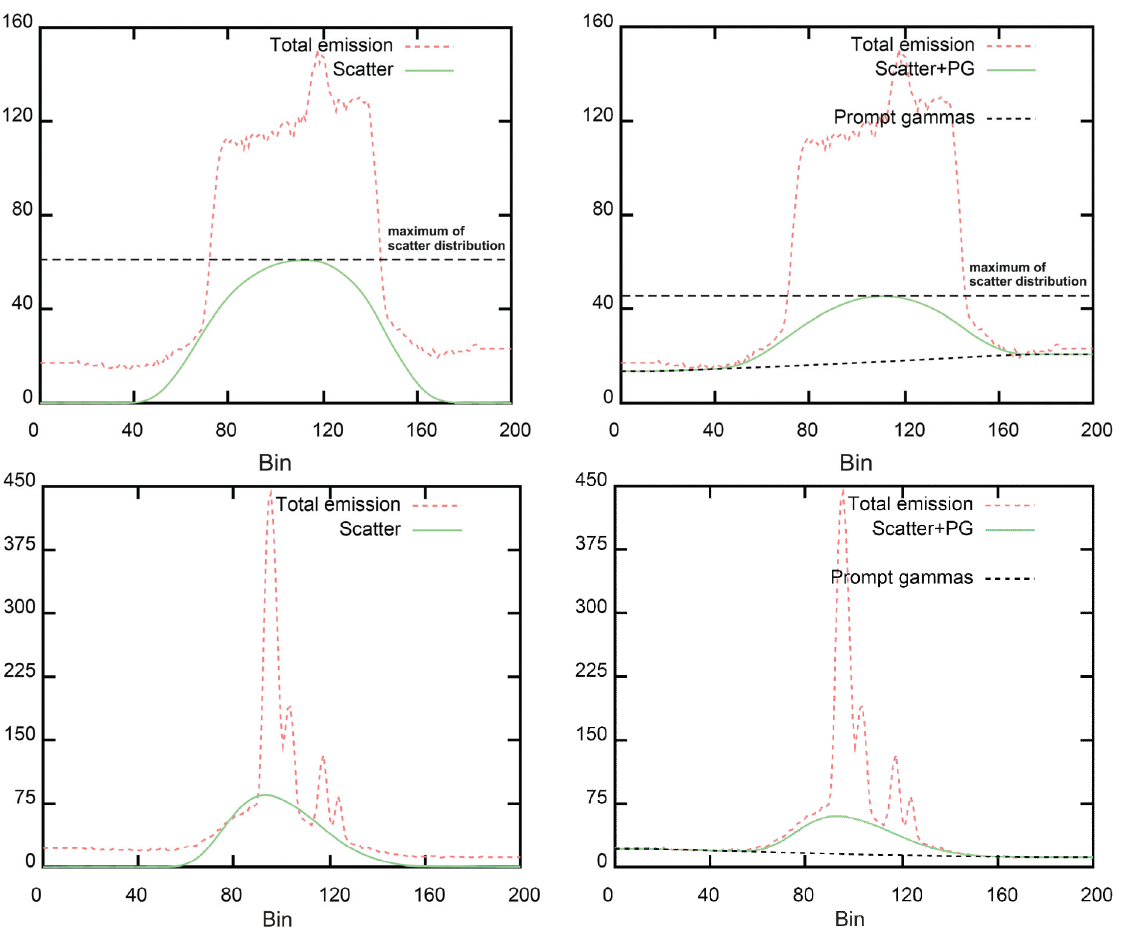
Figure 5. Sinograms of I-124 phantom images with PGC (right) and without PGC (left), top: with background activity, bottom: without background activity.